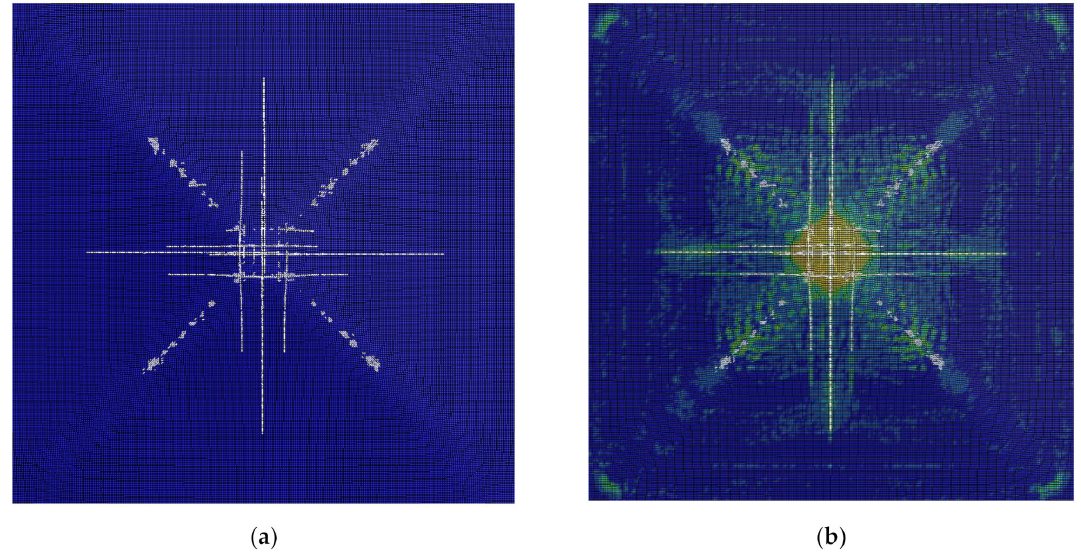
Figure 4. Reverse side of a damaged slab from the batch A2: ( a ) Cracks; ( b ) Cracks and crack opening strain color